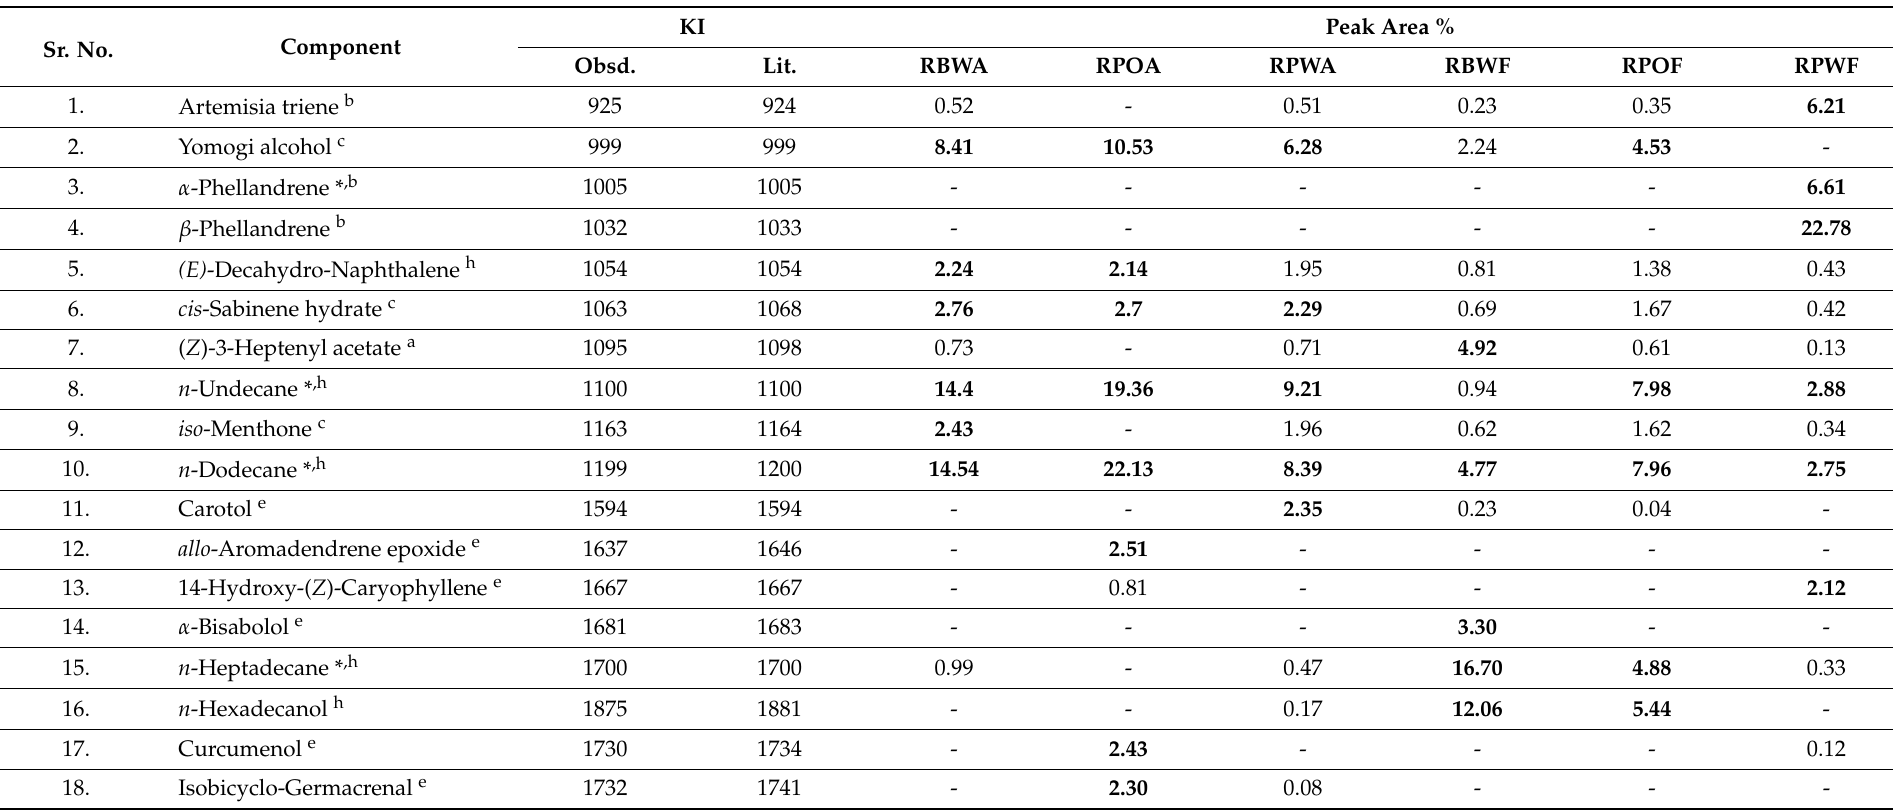
Table 1. Volatile constituents identified from the essential oils of the aerial parts and flowers of the three Rosa varieties (the most abundant components ≥ 2%). Sr.